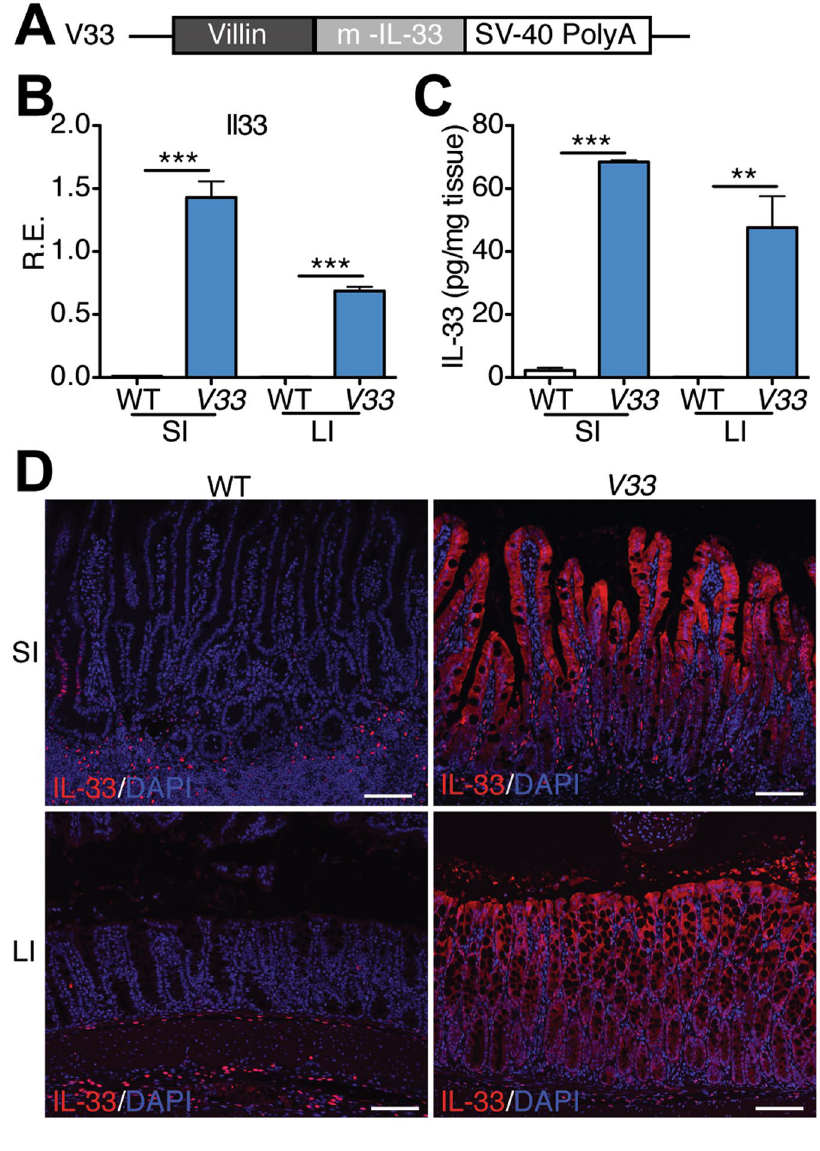
Figure 2. Generation of transgenic mice expressing IL-33 in the gut epithelium. ( A ) Scheme for generation of V33 mice. A transgene encoding IL-33 mature form (m-IL-33) under the control of the murine villin promoter (9 kb) was used to generate V33 mice. ( B ) Relative expression levels of transgenic IL-33 mRNA were analyzed by qPCR in the small intestine (SI) and large intestine (LI) of wild-type (WT) and V33 mice. Data were normalized to the expression levels of the Ubiquitin transcript. Means ± s.e.m., n = 6 per group. *** P < 0.001, one-way ANOVA. ( C ) Enzyme linked immunosorbent assay of IL-33 in the gut explants from WT and V33 mice. Data were normalized to the weight of the intestine explant. Means ± s.e.m., n = 4 per group. ** P < 0.01, *** P < 0.001, one-way ANOVA. ( D ) Immunofluorescence staining for IL-33 (red) in the gut of WT and V33 mice. Cell nuclei were counterstained with DAPI (blue). Notice that transgenic expression of IL-33 in the cytoplasm of intestinal epithelial cells in V33 mice. Scale bars, 50 μ